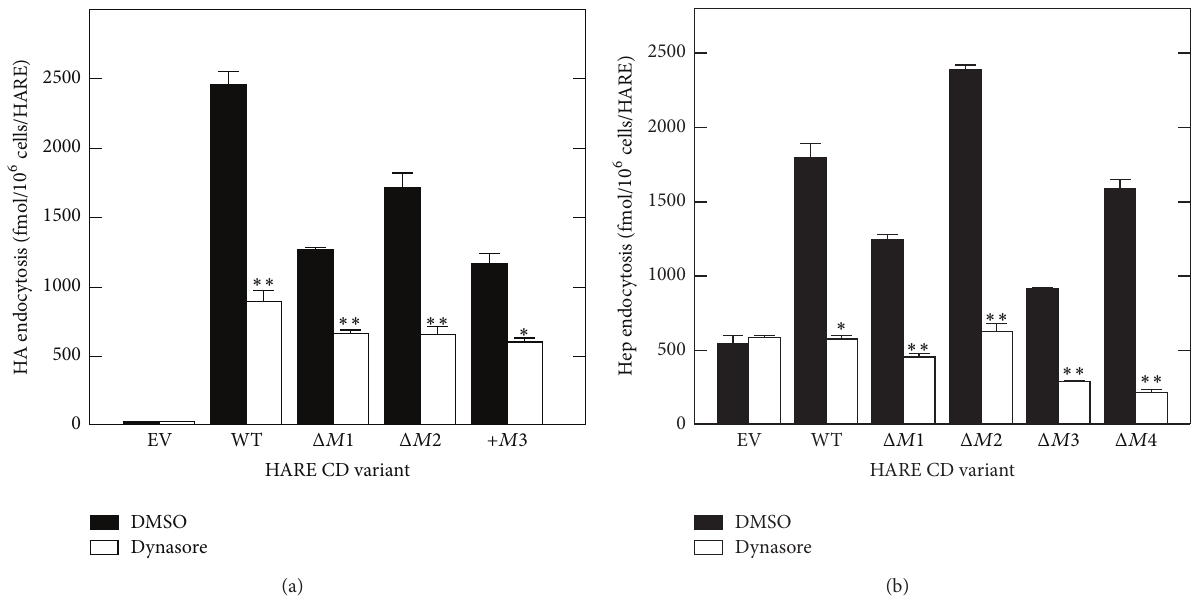
Figure 6: Endocytosis of HA and Hep by HARE CD variants is blocked by a dynamin inhibitor. WT cells were washed and preincubated in Endocytosis Medium as in Figure 2 and pretreated in medium with DMSO alone (black) or with 300 𝜇 M dynasore (white) at 37 ∘ C for 30 min. The medium was then replaced with fresh media containing DMSO alone or dynasore and 125 I-labelled HA (a) or Hep (b). The cells were incubated at 37 ∘ C for 4h and specific cell-associated ligand was determined as noted in Methods section. Values are the means ± SE ( 𝑛 = 3 ) and significant differences (Student’s 𝑡 -test) between treated and control samples are indicated: ∗ 𝑃 < 0.005 ; ∗∗ 𝑃 < 0.0005